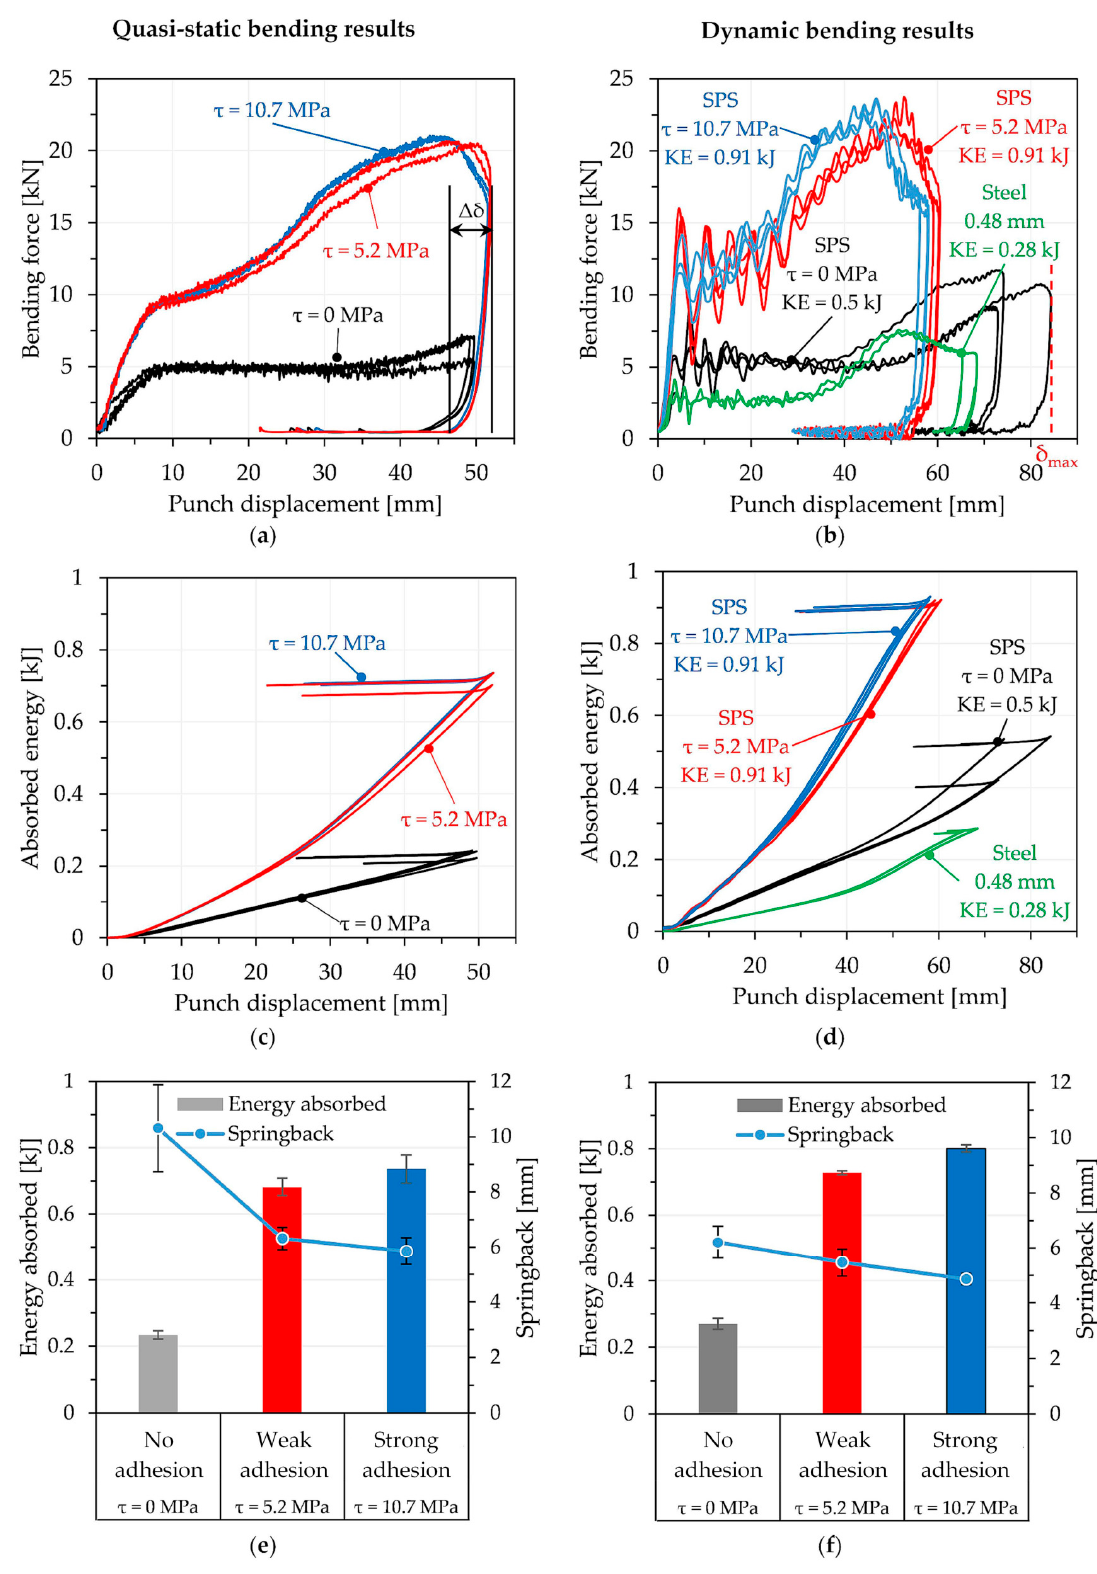
Figure 7. Three-point bending test results of the top-hat crashboxes in terms of the absorbed energy at the quasi-static ( a , c ) and the dynamic ( b , d ) loading rates, as well as a summary of the results at a punch displacement of δ = 50 mm in ( e , f ) the springback results.